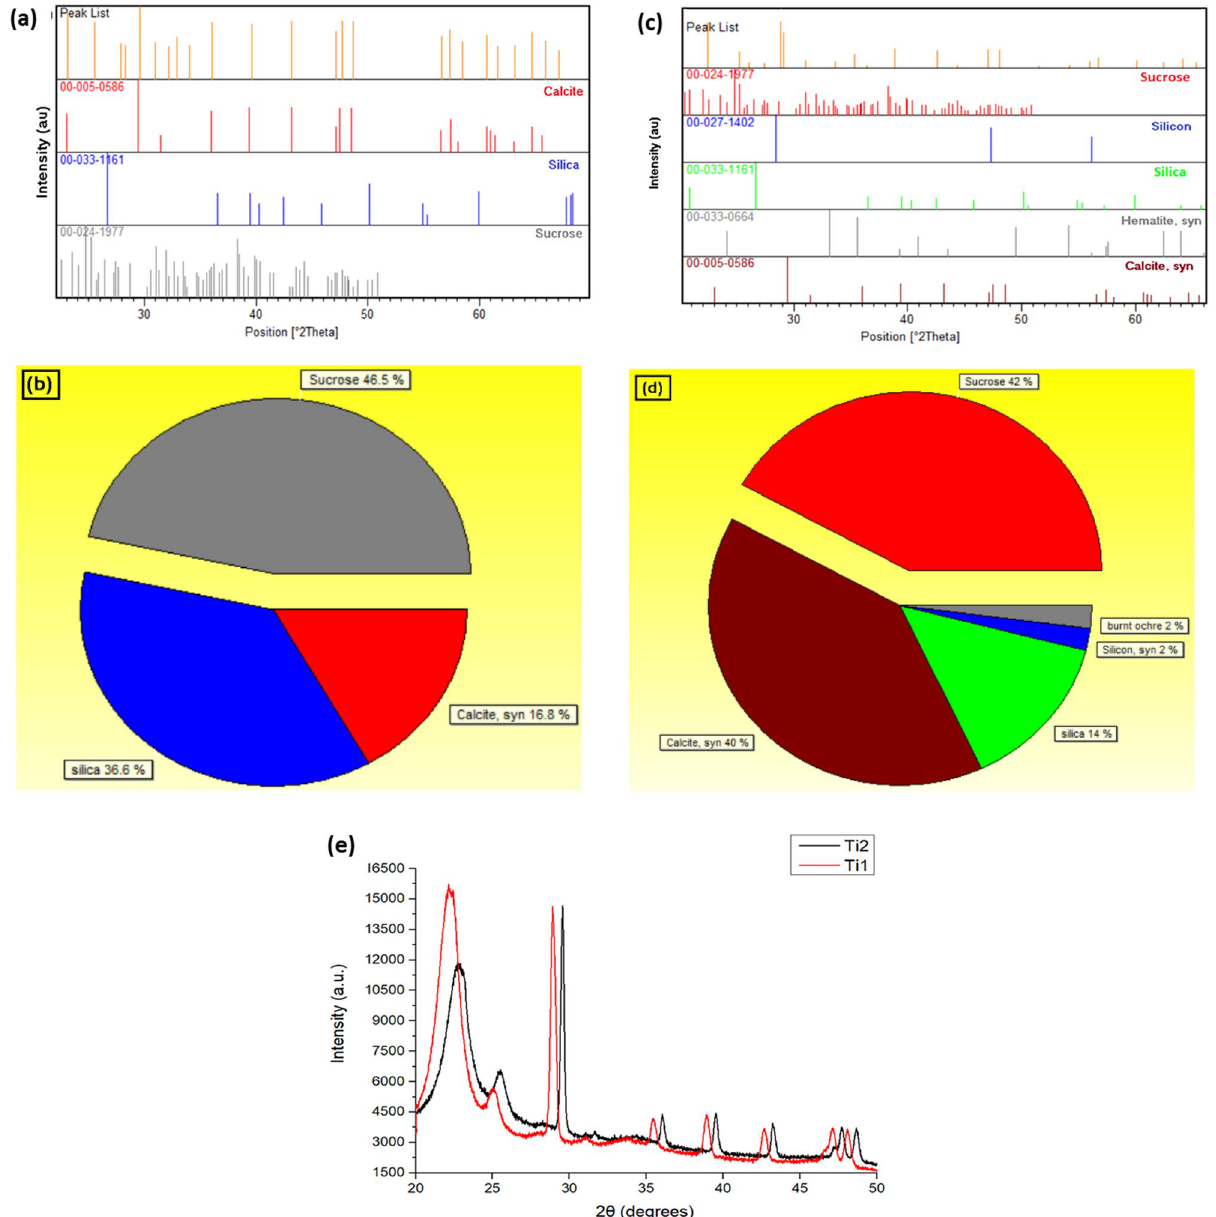
Figure 2. XRD peak analysis of: ( a , b ) TEOS and ( c , d ) TMMS dip coated paper respectively; ( e ) XRD intensity plot for paper dipped 5 times in Ti1 and Ti2. (Pan Analytical X’pert Powder Diffractometer/ X’Pert Highscore